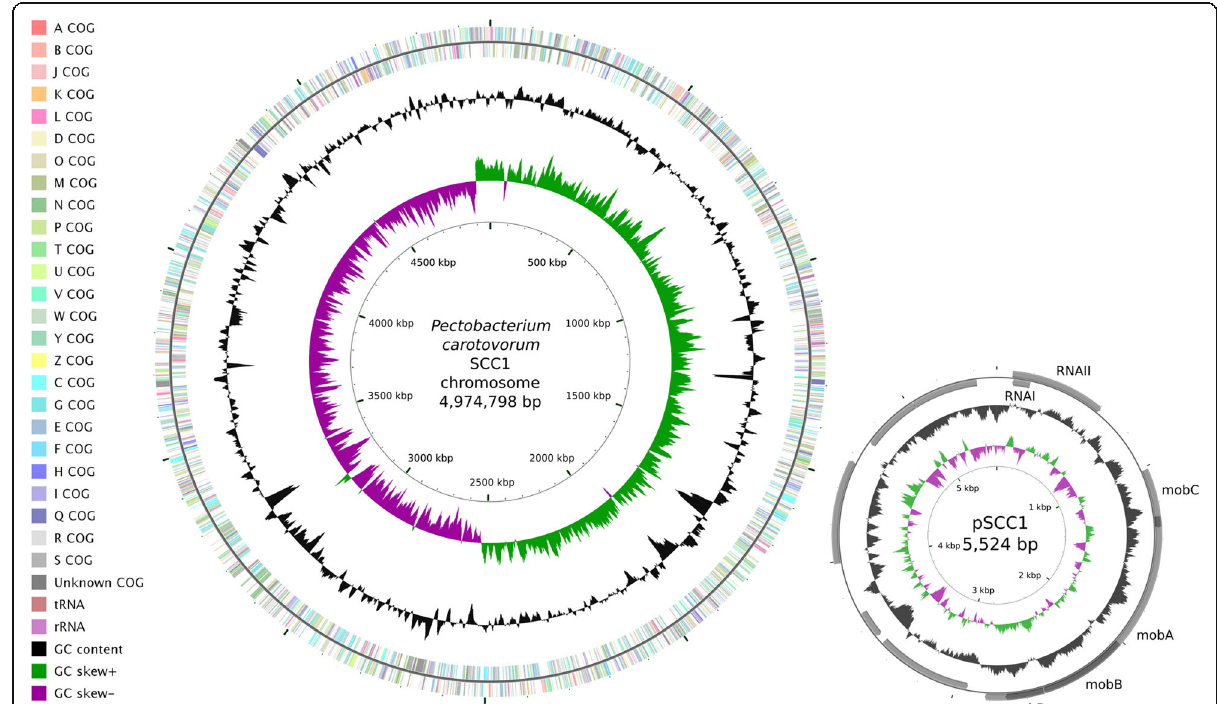
Fig. 3 Circular maps of the chromosome and plasmid of Pectobacterium carotovorum SCC1. Rings from the outside to the center: Genes on forward strand (colored by COG categories), Genes on reverse strand (colored by COG categories), GC content, GC skew. Maps were generated using the CGView Server